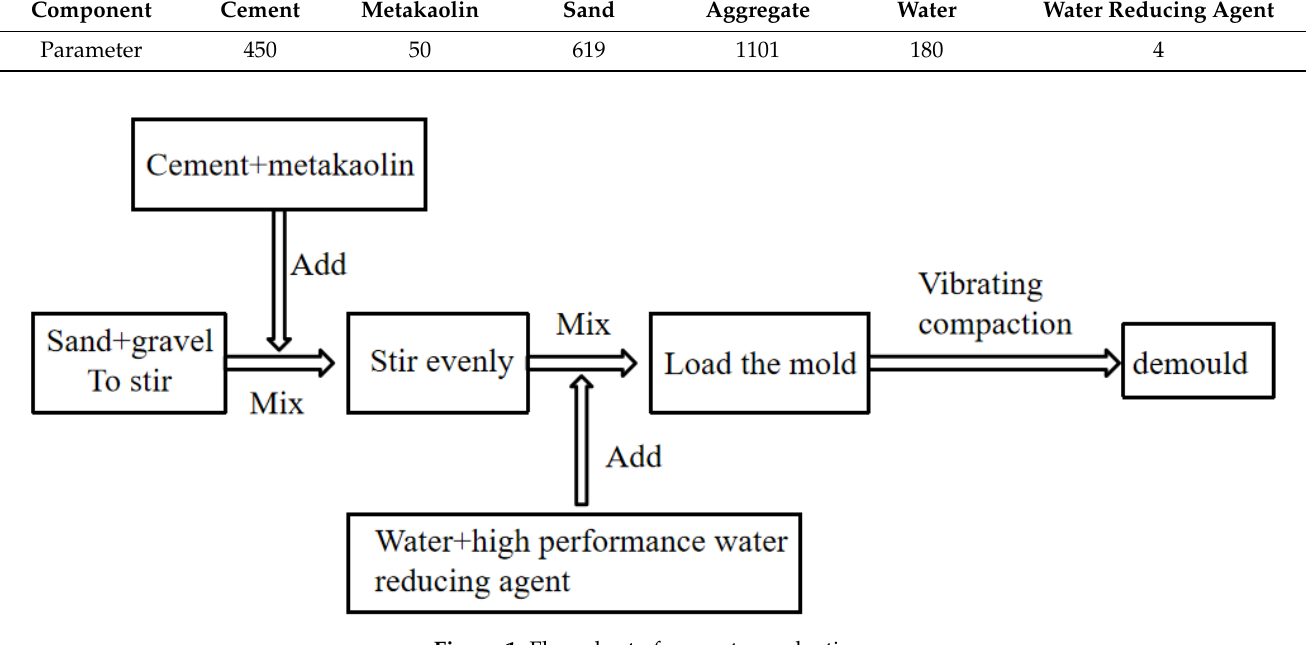
Figure 1. Flow chart of concrete production.